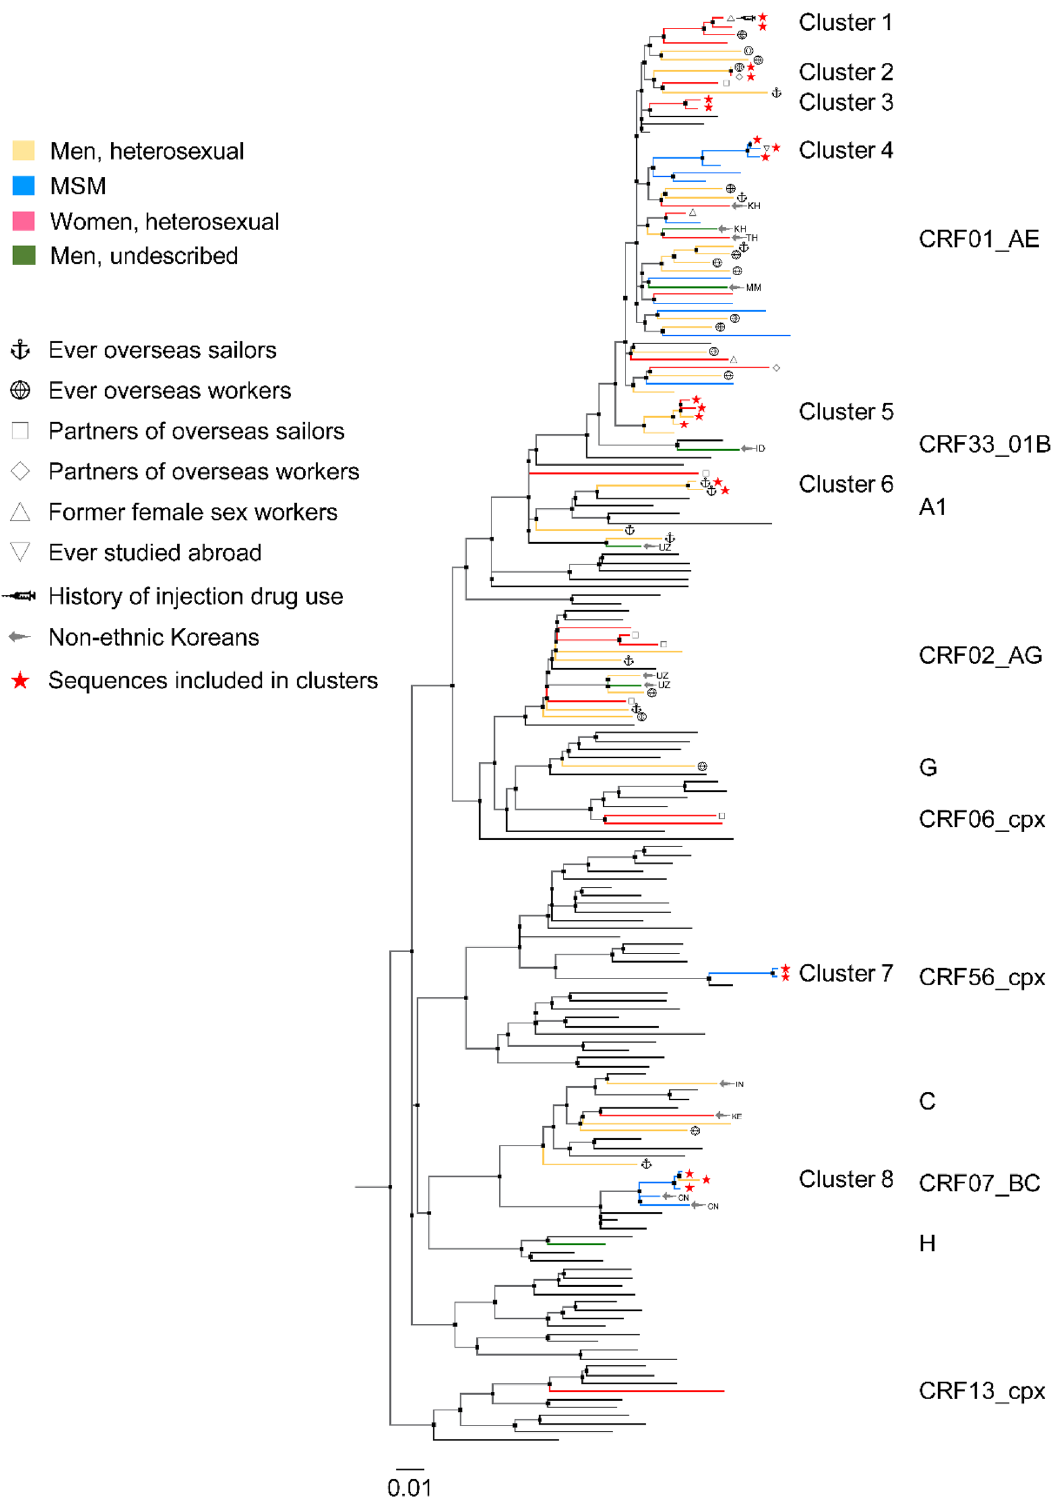
Figure 6. Transmission clusters in the maximum likelihood phylogenetic tree. The maximum likelihood tree was constructed using MEGA version 10.1.8 (https:// www. megas oftwa re. net) under the GTR + G + I model with 1000 bootstrap replicates. The black branch color represents the reference sequences, and the colored branches represent transmission risk groups. Diameters of internal node circles reflect bootstrap values. Anchor emojis depict overseas sailors, and the globes with meridians represent overseas workers. Squares indicate the partners of overseas sailors, and diamonds indicate the partners of overseas workers. Triangles indicate female sex worker, and reverse triangles indicate subjects who had ever studied abroad. Arrows and two-letter country codes indicate foreigners. The syringe emoji indicates an injection drug user. Sequences included in clusters are indicated by red stars and their cluster names. CRF circulating recombinant form, CN China, ID Indonesia, IN India, KE Kenya, KH Cambodia, MM Myanmar, TH Thailand, UZ